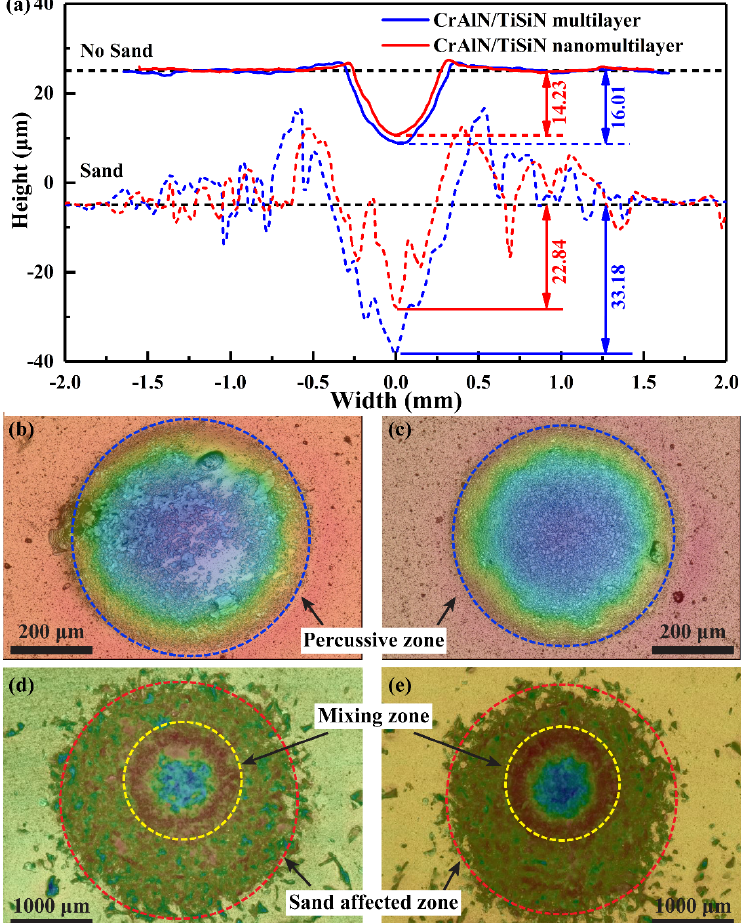
Figure 10. Wear profiles and surface cloud chart of two coatings with and without sand: ( a ) Wear scar profiles; ( b , d ) CrAlN/TiSiN multilayer with and without sand; ( c , e ) CrAlN/TiSiN nanomultilayer with and without sand.